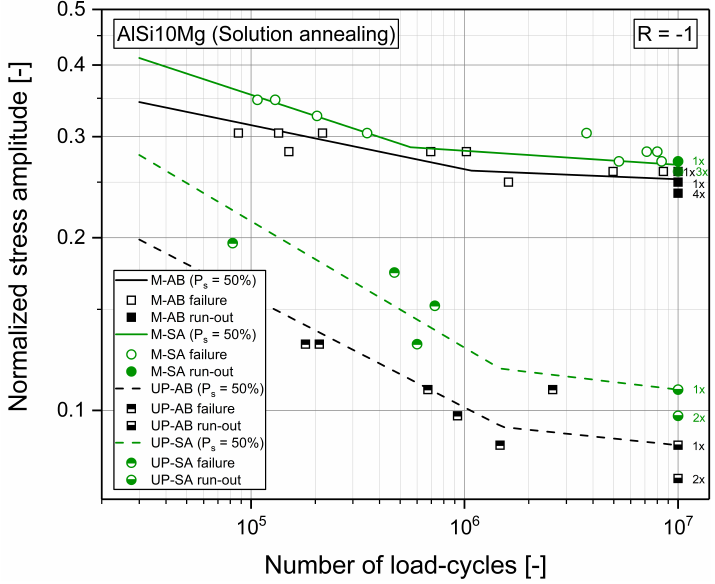
Figure 10. S/N curves for the AB and SA test